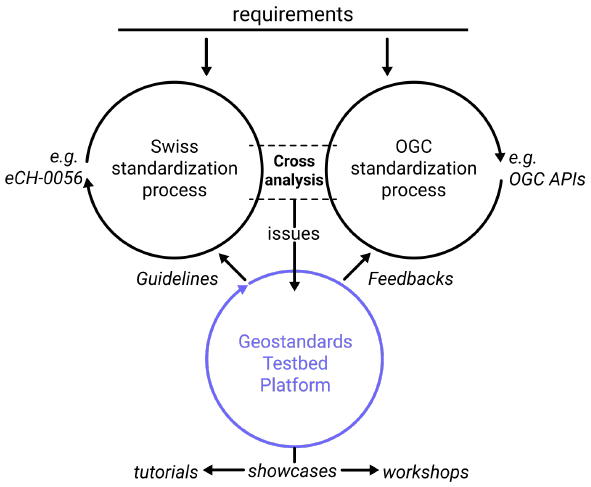
Figure 1. Proposed vision to connect Swiss and